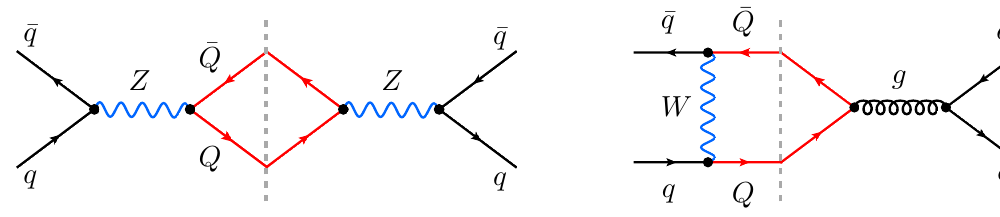
Figure 12 . Left: tree-level s -channel Z -boson exchange contribution to asymmetric heavy-quark production at O ( (cid:11) 2 ). Right: interference contribution between t -channel W -boson exchange and tree-level s -channel gluon exchange. In both diagrams the relevant particle cuts are represented by a dashed line. See text for further